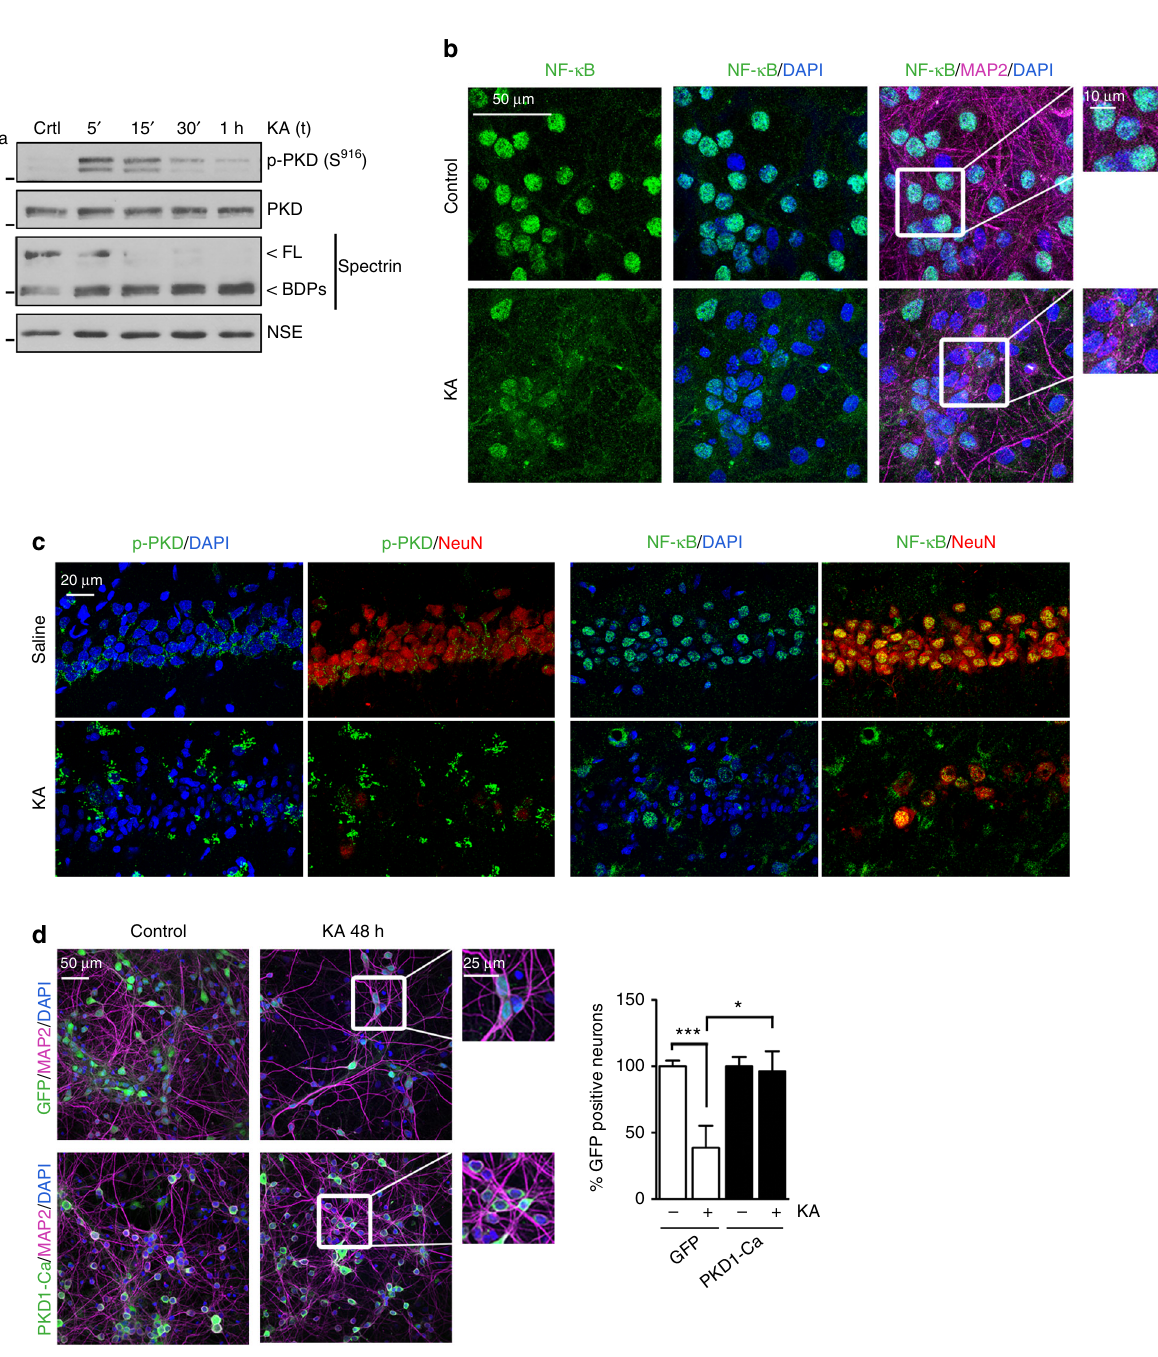
Fig. 6 PKD1 mediates neuroprotection from in vitro KA-induced excitotoxicicity. a Primary cortical neurons were stimulated with excitotoxic concentrations of KA (50 μ M) for various periods of time and PKD activity and Spectrin processing were determined by immunoblotting. Representative immunoblots are shown ( n = 3 independent experiments). b Representative images of MAP2, NF- κ B, and DAPI staining of neurons treated with KA for 4 h. Zoom-boxed regions are also shown. ( n = 3 independent experiments). c Brain slices from adult male Wistar rats treated with saline or KA (8.5 mg per kg, i.p.) were stained with p-PKD(S916) or NF- κ B in combination with NeuN and DAPI. Representative confocal microscopy images of the hippocampal CA1 region are shown ( n = 3 animals per conditions). d Representative images of GFP fl uorescence and MAP2 and DAPI staining of primary cultured neurons transduced with GFP or PKD1-Ca lentivirus and treated with KA for 48 h. Zoom-boxed regions are also shown. (Right panel) Neuronal survival was determined counting the number of living GFP+ neurons 48 h after KA treatment and shown relative to the number of GFP+ neurons transduced with GFP or PKD1-Ca in untreated conditions ( n = 200 – 400 neurons per condition; n = 3 independent experiments). Data are expressed as mean + s.e.m. analyzed with two- tailed unpaired Student's t test. * P < 0.05, *** P <